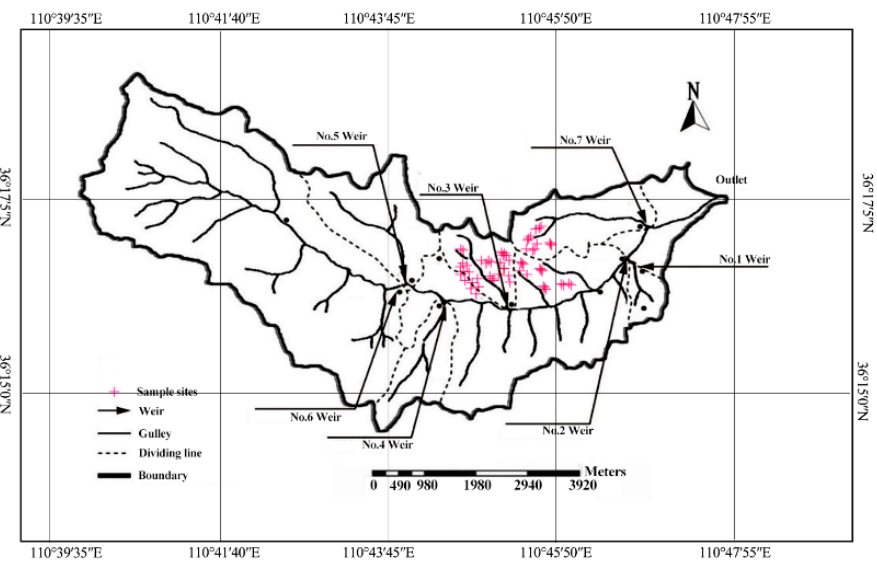
Figure 1. The location of the sample plots at the Caijiachuan watershed of the Loess Plateau,